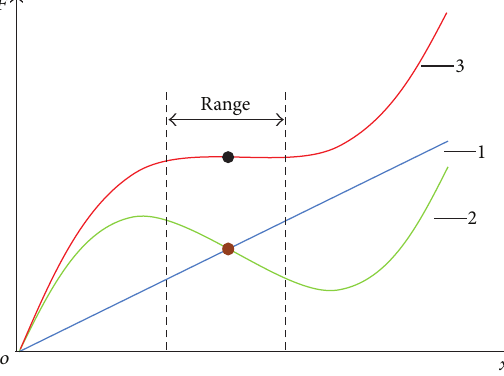
Figure 3: The disk spring under axial